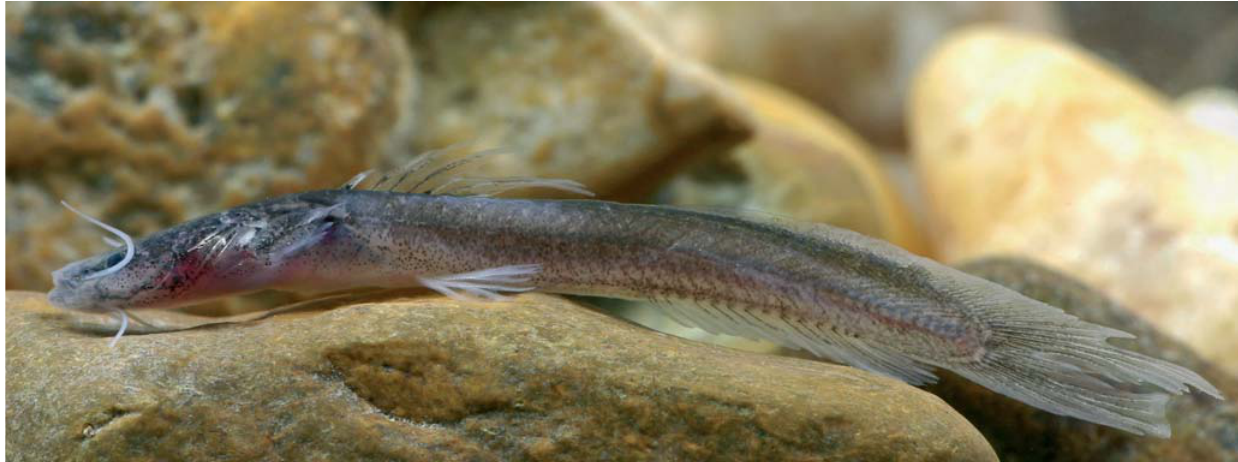
Fig. 5. Gladioglanis machadoi , INPA 29008, 23.1 mm SL, live specimen. Photograph by V. L.